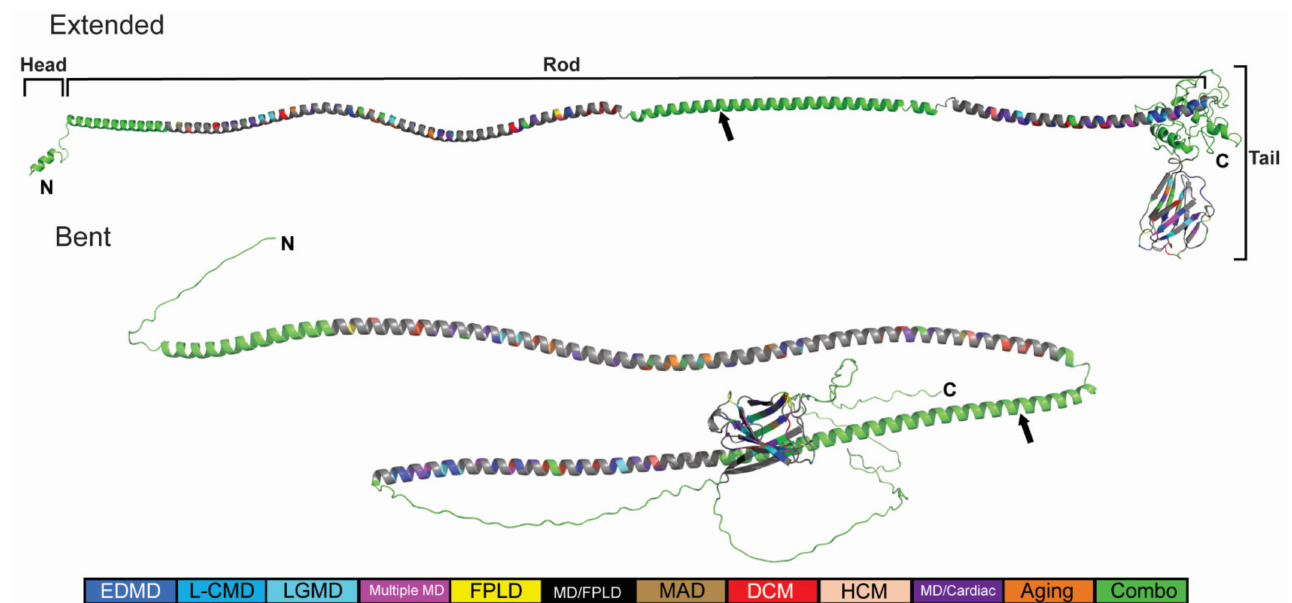
Figure 3. In silico predicted full-length models were generated for lamin A/C. Deep learning based predictive full-length model of a lamin A/C monomer generated by trRosetta [45] (green) in which the previously determined structures were spliced into the model (gray with color-coded amino acids). trRosetta predicted an “extended” lamin A/C monomer (top). Full-length lamin A/C model was generated by AlphaFold v2.0 and disease-associated residues were color-coded [49]. The top four out of five predicted models possessed a bent conformation